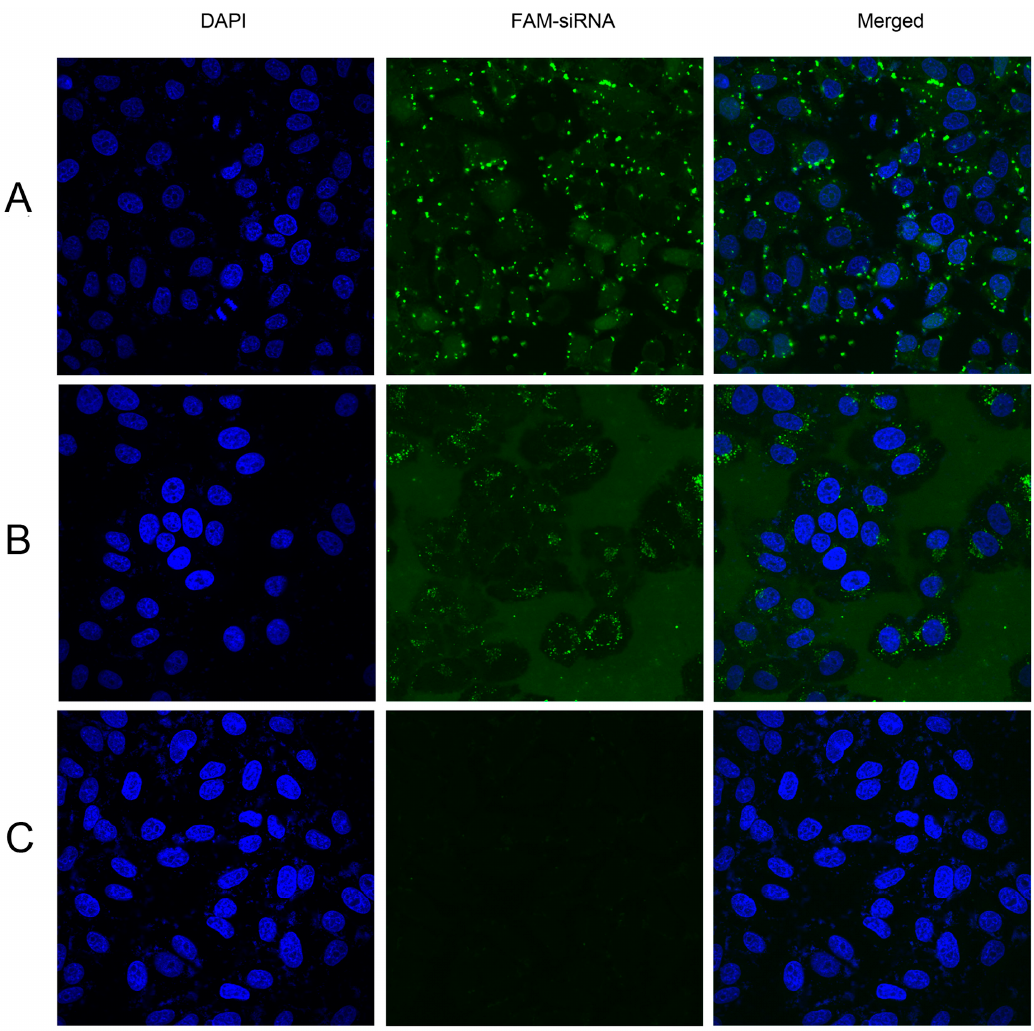
Figure 5. Confocal microscopy analysis of cell transfection in vitro. DAPI (4 ′ ,6-diamidino-2-phenylindole), FAM-siRNA, and merged images are displayed separately. HepG2 cells were treated with ( A ) FAM-siRNA/liposome, ( B ) c(RGD) 2 -9R/FAM-siRNA, and ( C ) FAM-siRNA alone, respectively. FAM-siRNA showed green fluorescence in the cytoplasm of HepG2 cells.